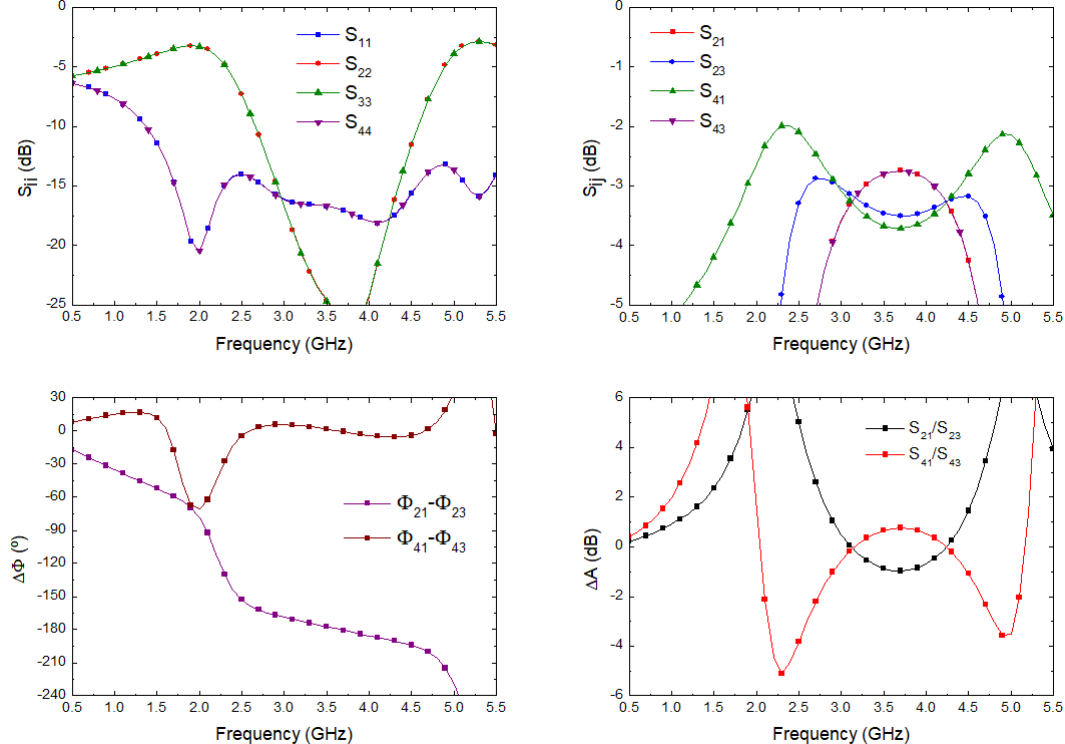
Figure 6. 180 ◦ hybrid coupler electromagnetic